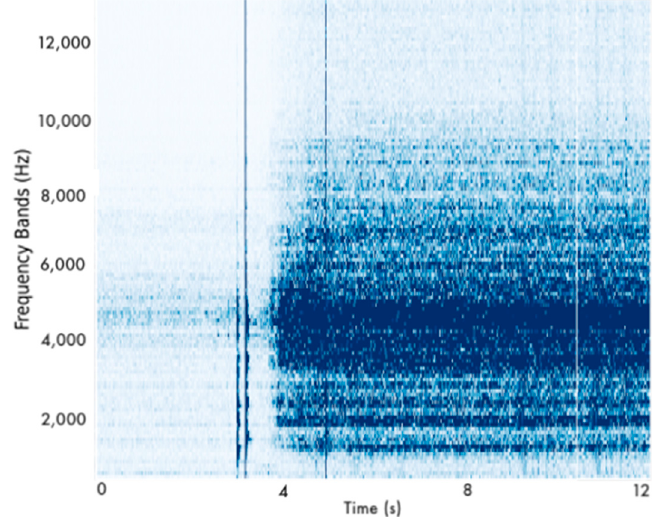
Figure 6. Example of spectrogram received by the CNN classifiers.